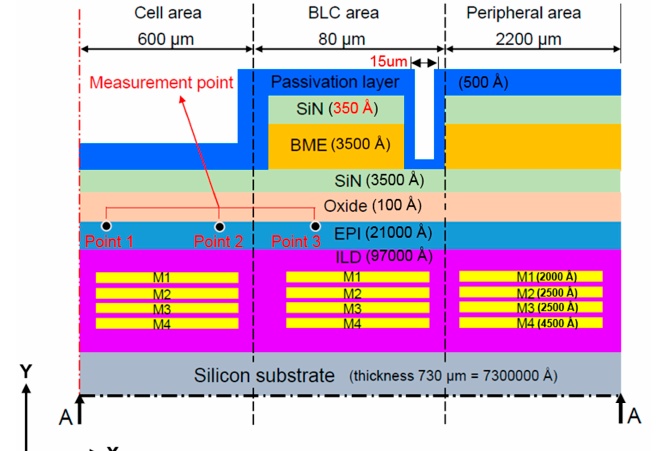
Figure 9. Side view (x-y plane) of Structure C showing the section of the stacked-film architecture along the line A–A.